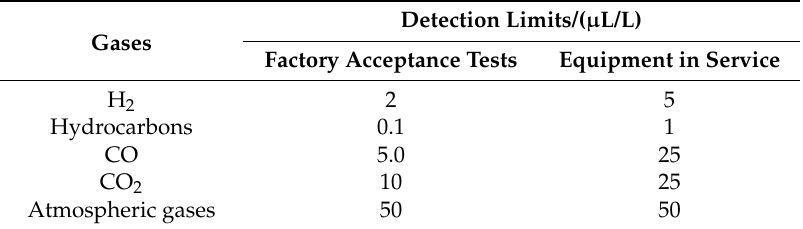
Table 1. Sensitivity requirements of a dissolved gas analysis (DGA) analyzer.